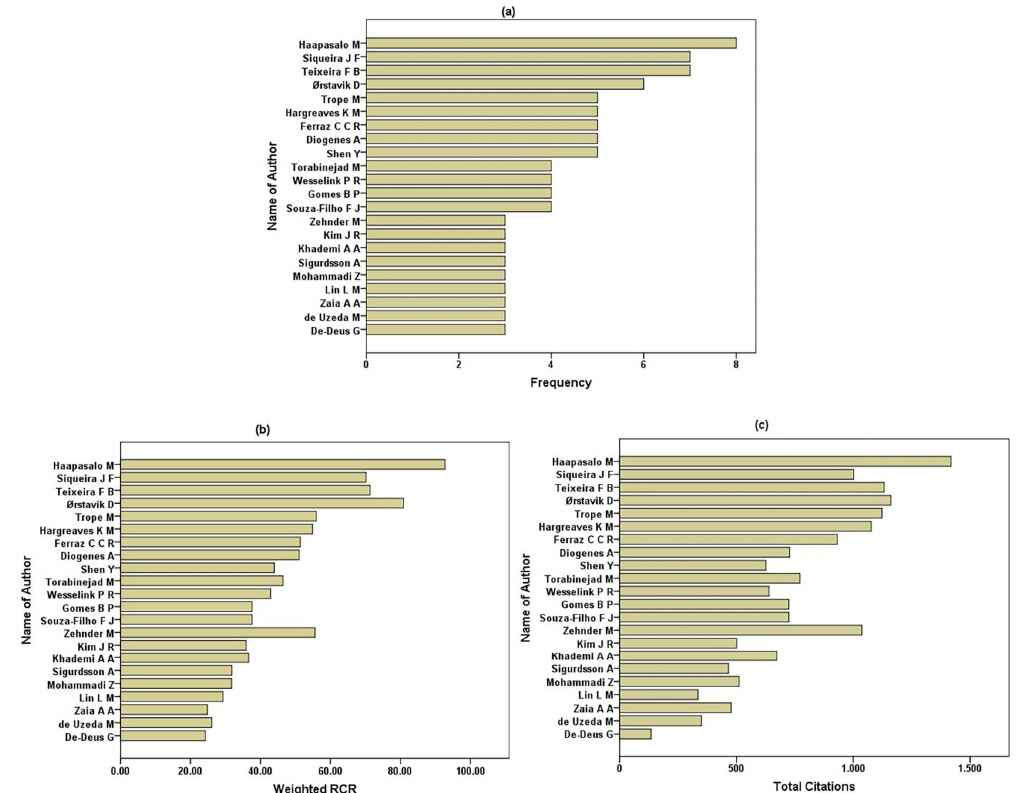
Figure 2. Authors of three or more articles of the 100 root canal disinfection articles with the highest relative citation rates. ( a ) Frequency, ( b ) weighted RCRs (sum of the RCRs for the articles of each author), and ( c ) total citations. Table 5. Study design and field of study of the top 100 most influential articles in root canal disin ‐ fection by the highest RCRs. 1990–2019. Weighted RCR, total citations. Median (interquartile range).